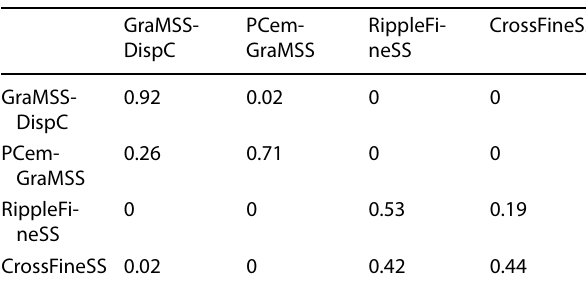
Table 4 Confusion matrix of four classes. Here, we consider four classes for